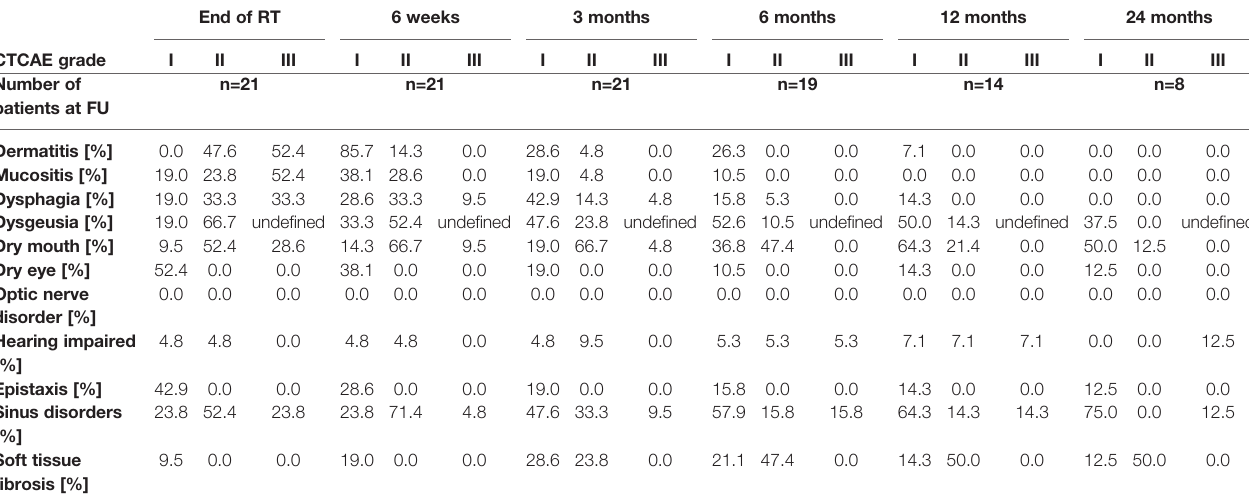
TABLE 4 | Treatment-related acute and late adverse events according to common toxicity criteria for adverse events (CTCAE V 5.0). End of RT 6 weeks